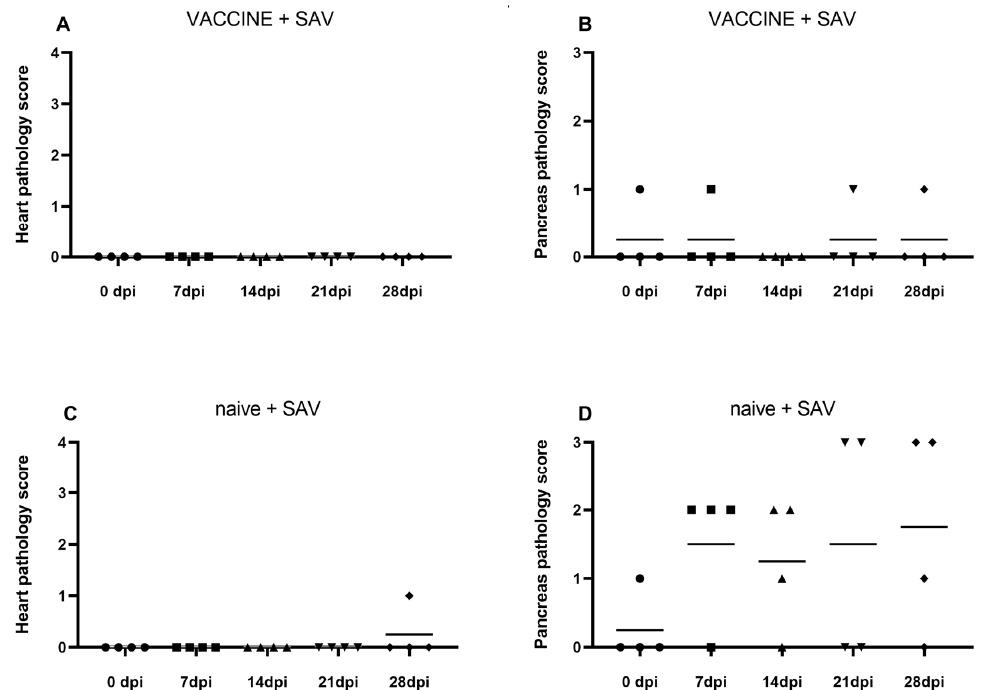
Figure 2. Graphs showing histological scores in heart and pancreas evaluating the impact of SAV infection at 7, 14, 21, and 28 days post injection in rainbow trout in ( A , B ) vaccinated and SAV challenged fish, and ( C , D ) naïve and SAV challenged fish over time. Heart is scored from 0–4, pancreas is scored from 0–3.